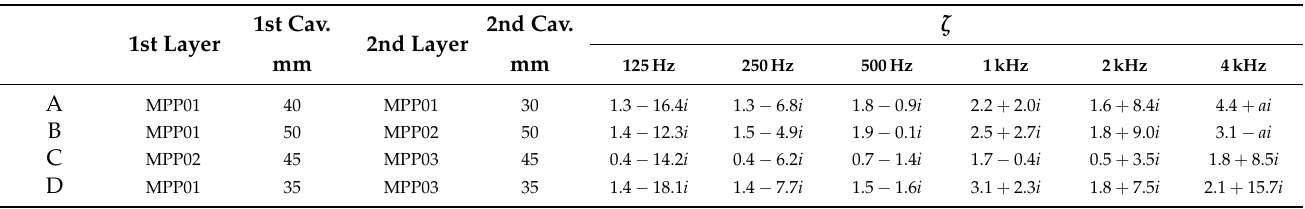
Figure 11. Sound absorption coefficient and normalized surface impedance of single-layer MPPs: MPP01 with an air cavity of D = 14.8 mm, MPP02 with an air cavity of D = 30 mm and MPP03 with an air cavity of D = 20 mm. Table 4. Specific normalised impedances corresponding to the four double-layer configurations. Octave band data were fitted based on the outcomes of the compensation model described in the